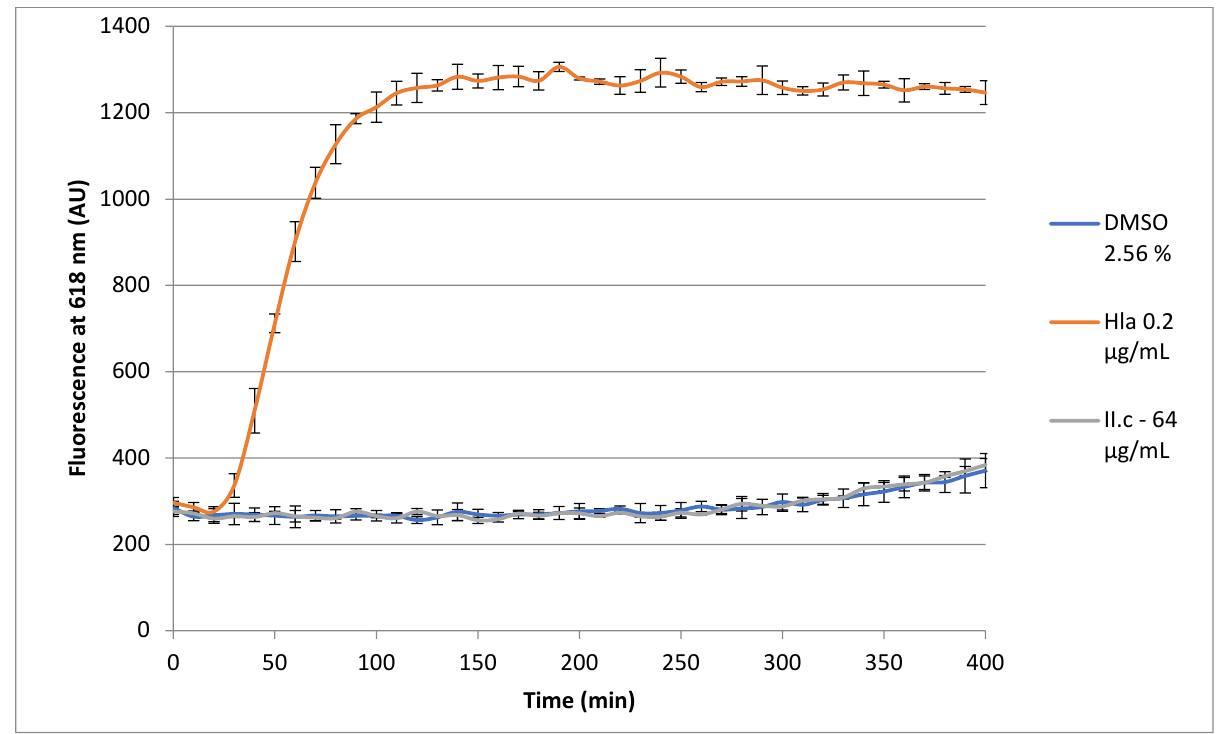
Figure 5. Effect of II.c on the growth of A549 cells.